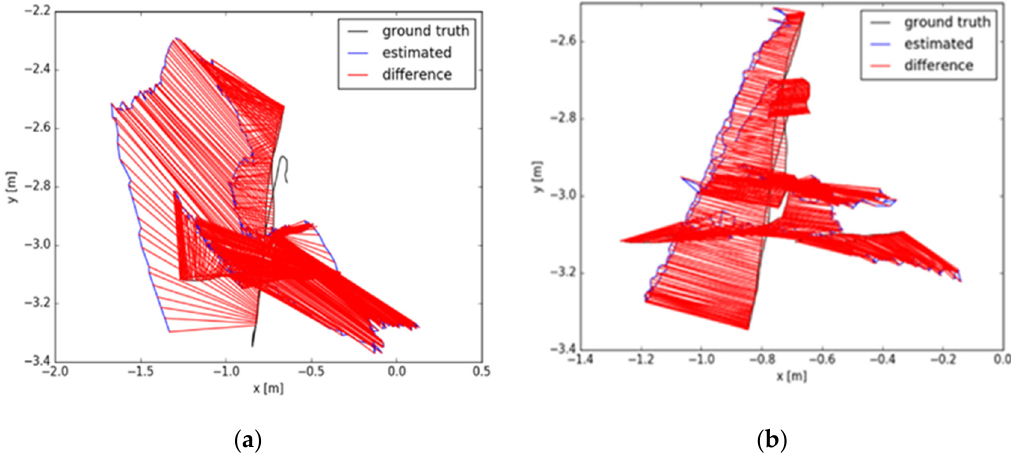
Figure 14. Absolute trajectory error of dataset one: ( a ) The absolute trajectory error of dataset one using ORB-SLAM2; ( b ) The absolute trajectory error of dataset one using instance SLAM based on CO-HDC.